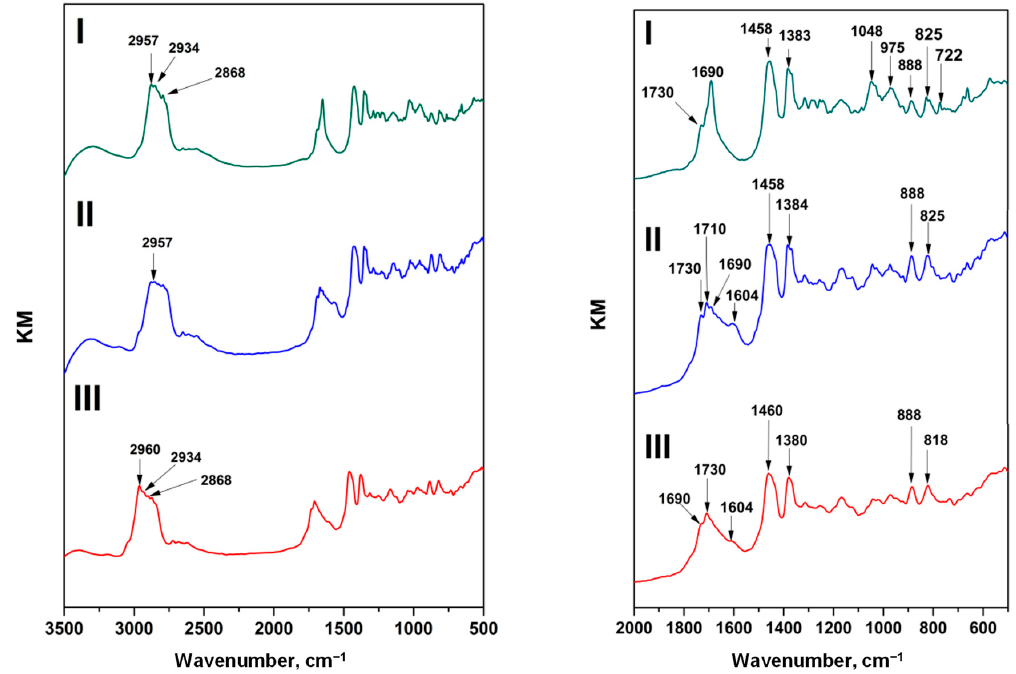
Figure 8. Kubelka–Munk-transformed diffuse reflectance spectra of resin varieties I, II, III from the island of Sumatra. The graph on the right depicts fingerprint region of the spectra (2000–500 cm − 1 ). Table 2. FT-IR bands assignment.